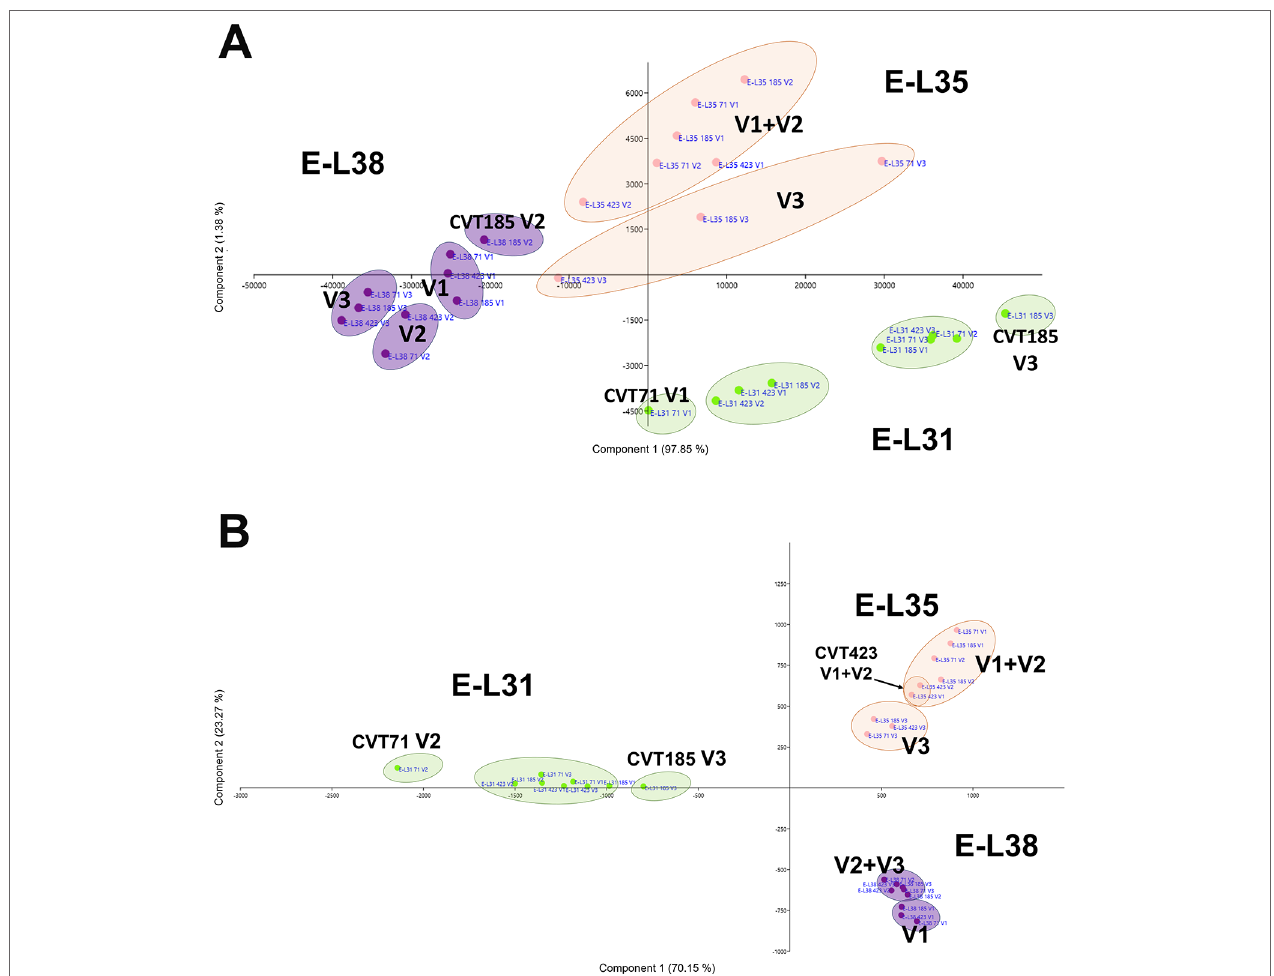
FIGURE 5 | C x E effect on developmental processes. Schematic representation highlighting how the three considered variables, ripening stage (E-L31, E-L35, E-L38), clone (CVT71, CVT423, CVT185), or vineyard (V1, V2, V3), affect the distribution of samples when genes belonging to (A) development and (B) cell wall metabolism were analyzed by PCA. Conversion between the modified E-L scheme and the extended BBCH scheme, E-L31 = 75 BBCH; E-L35 = 81 BBCH; E-L38 = 89 BBCH.